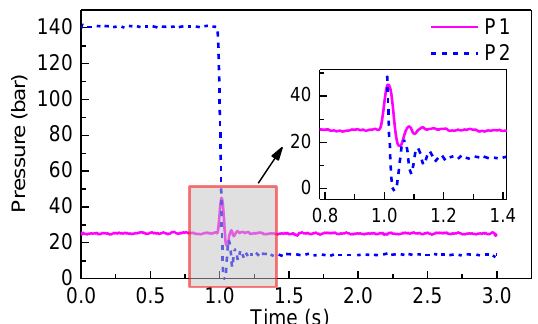
Figure 14. Position tracking under external